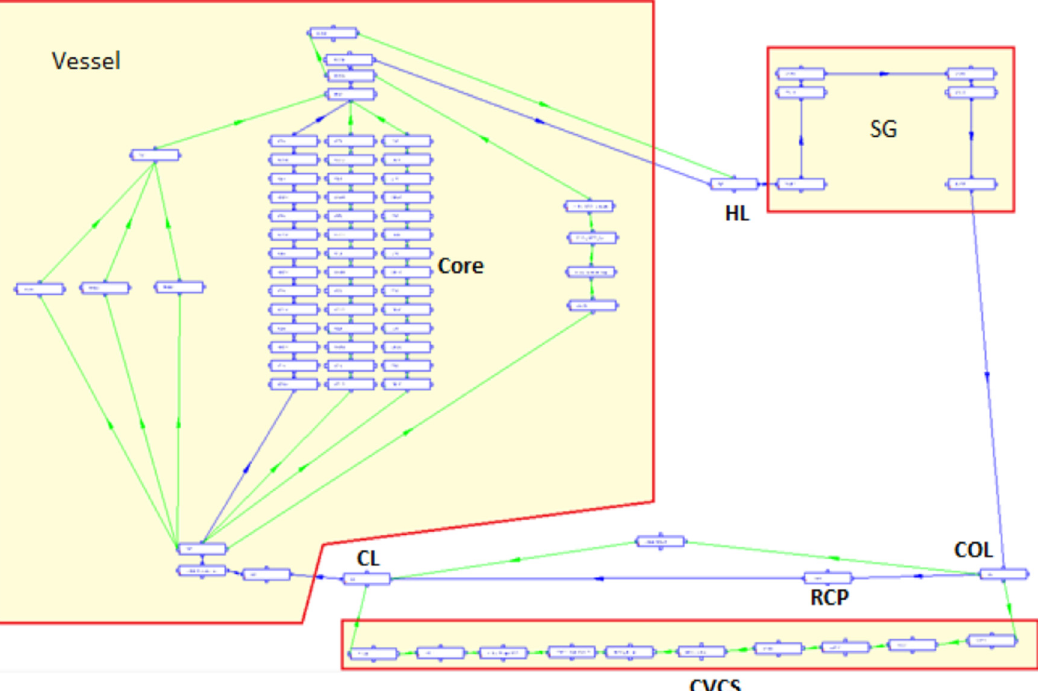
Fig. 1. Control volumes of a typical PWR (HL: Hot leg / SG: Steam generator / COL: Crossover leg / RCP: Reactor coolant pump / CL: Cold